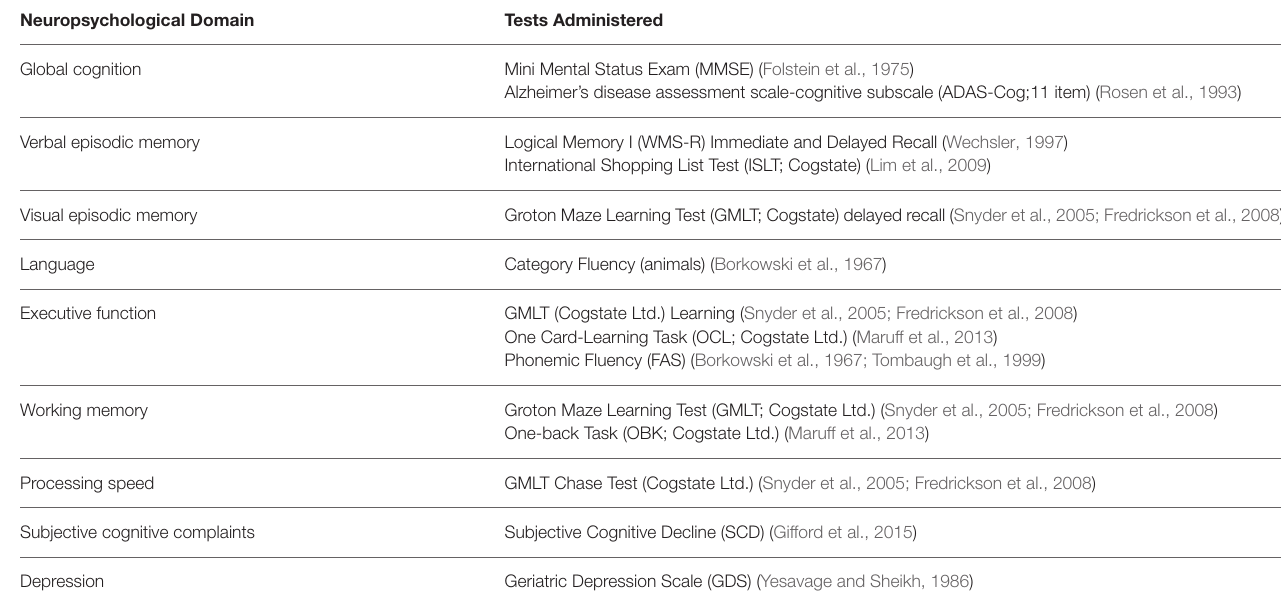
TABLE 1 | Neuropsychological outcome measures used in a compassionate use IND trial of DFMO in a single case. Neuropsychological